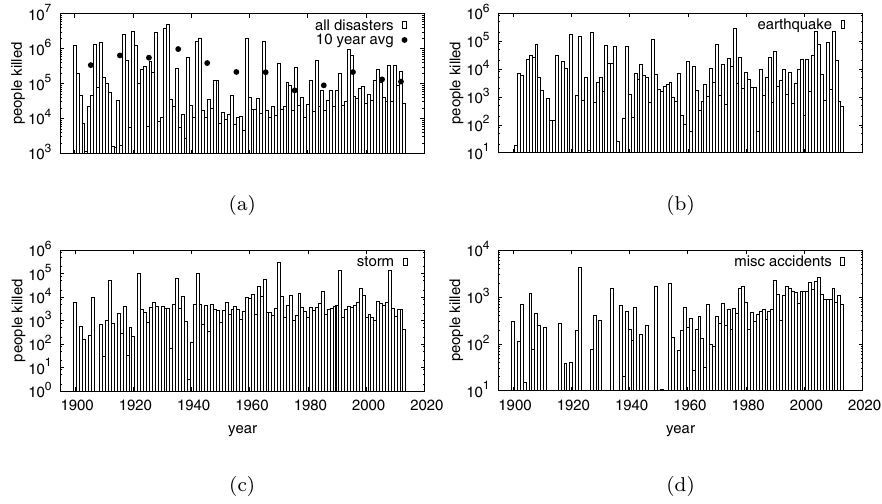
Fig. 2. Statistics of fatalities over years for disasters during 1900 – 2013 according to the EMDAT database 47 : (a) Number of people died due to all disasters, along with 10 years averages indicating a decreasing trend with time. Number of human deaths due to (b) earthquake, (c) storms and (d) miscellaneous accidents in the same period.